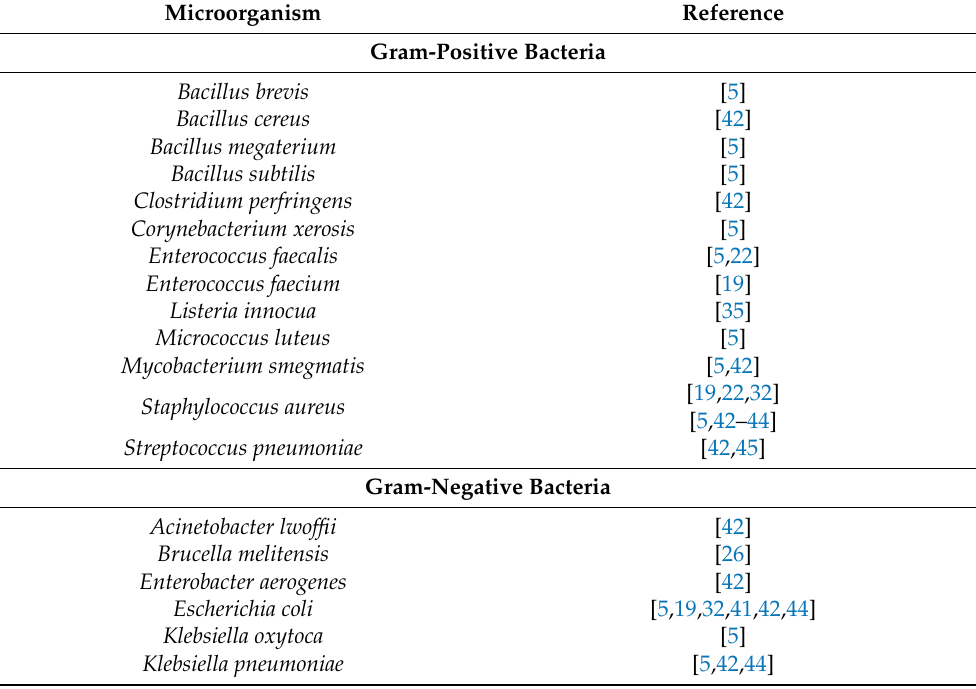
Table 5. Microorganisms tested with the Origanum syriacum essential oil and the relative